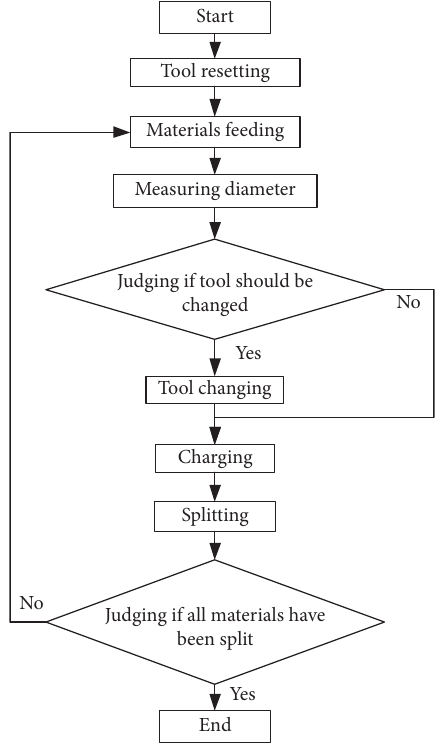
Figure 4: Workflow chart of intelligent bamboo-splitting machine.